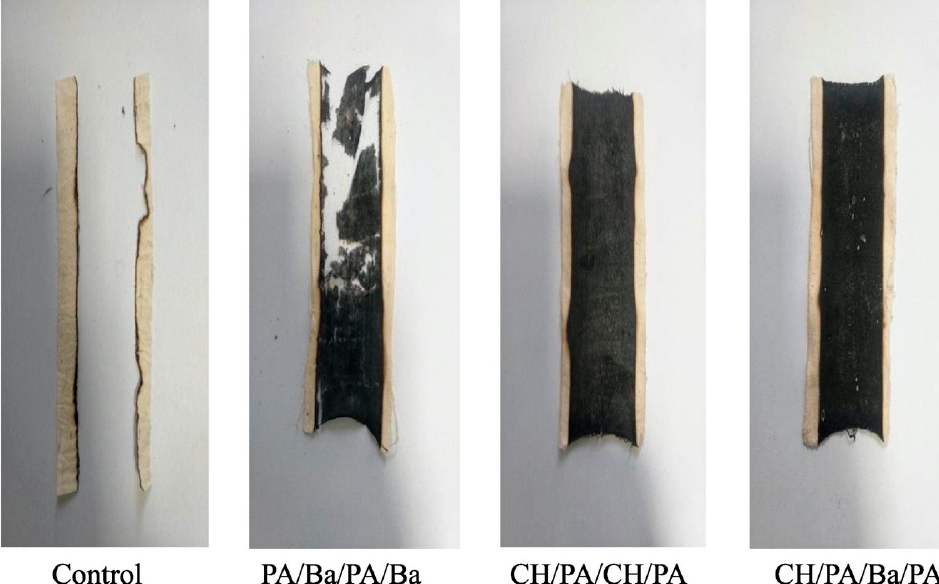
Figure 12. Residues at the end of the flame spread tests performed in a horizontal configuration. PA/Ba/PA/Ba: quad-layer made of phytic acid/Ba 2+ /phytic acid/Ba 2+ ; CH/PA/CH/PA: quad-layer made of chitosan/phytic acid/chitosan/phytic acid; CH/PA/Ba/PA: quad-layer made of chitosan/phytic acid/Ba 2+ /phytic acid. Reprinted with permission from [42]. Copyright 2019, Elsevier.